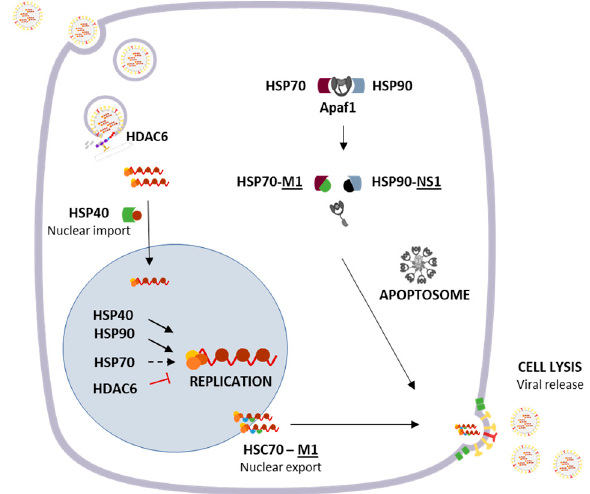
Figure 2. Schematic representation of the interplay between cellular protein chaperones and IAV proteins throughout viral life cycle. Upon attachment with the cellular surface proteins, the virus is internalized by endocytosis and hijacks the cellular aggresome processing machinery (HDAC6) for capsid uncoating and genome release into the cytoplasm. Afterwards, the viral genome (vRNP) is imported to the nucleus together with Hsp40/DnaJB1, where it undergoes transcription and replication. Several host chaperones are involved in mediating viral replication, either by favoring or constraining viral polymerase activity. To spread infection, the virus can additionally induce host cell lysis by inducing apoptosis, a process in which host chaperones are also involved. Dotted lines refer to mechanisms associated to controversial results, as explained in the text. Viral proteins are represented underlined.